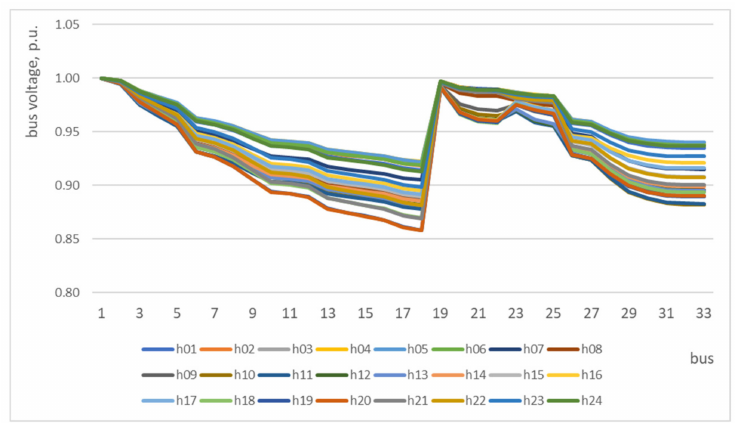
Figure 18. The bus voltages in the IEEE 33-bus system without compensation, for each hour from the analyzed day.